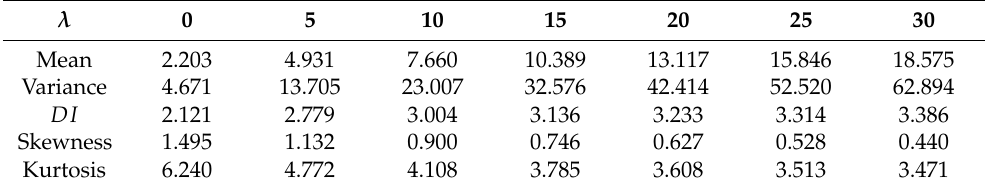
Table 1. Summary statistics for the PncL distribution for α = 0.01, β = 0.9, θ = 0.5, and various values of λ .